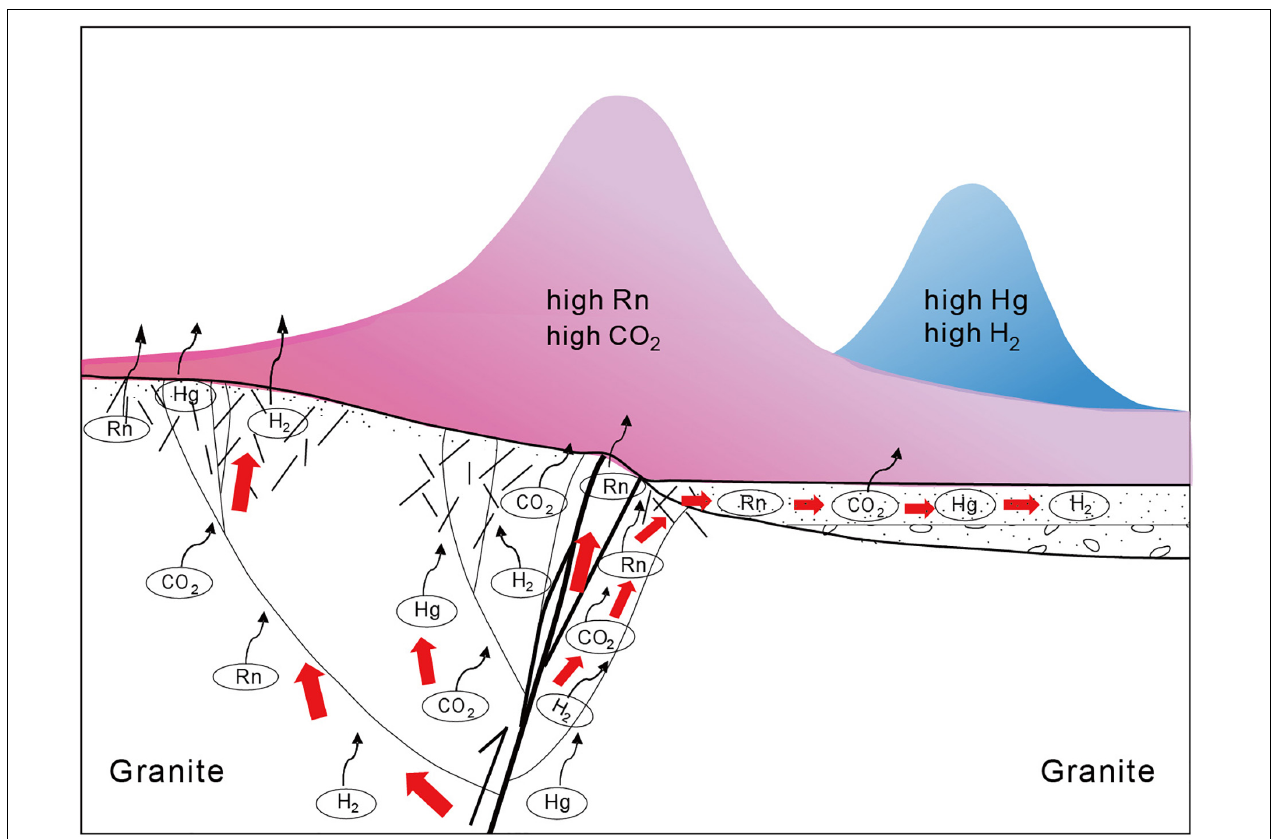
FIGURE 6 | Schematic diagram of thrust